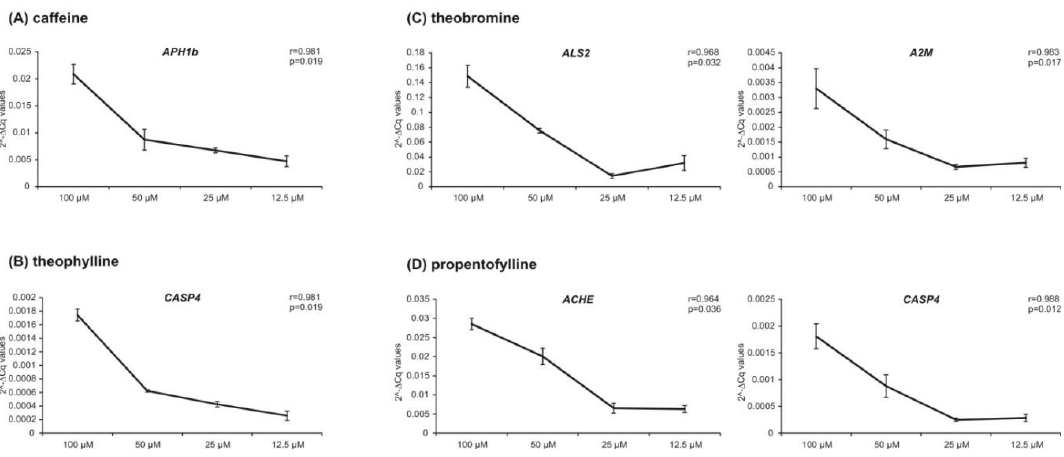
Figure 7. Analysis of dose-dependent effects of methylxanthines . The expression of APH1b , ALS2 , A2M , CASP4 , ACHE and CASP4 are plotted against the concentrations of caffeine ( A ), theophylline ( B ), theobromine ( C ) and propentofylline ( D ) in diagrams, respectively. The Pearson correlation coefficient r and the corresponding p -value are shown for each gene.